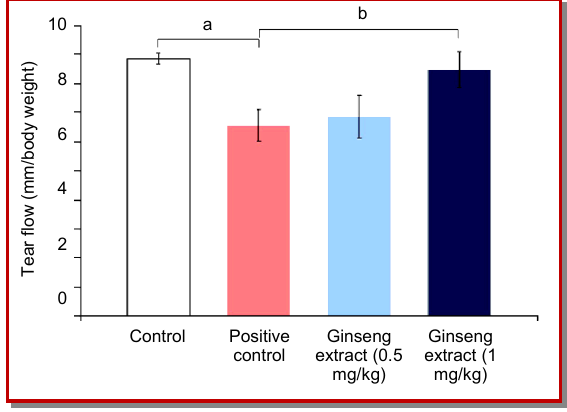
Figure 1: Effects of ginseng extract (0.5 and 1 mg/kg) admin- istration on tear secretion in benzalkonium chloride-induced dry eye syndrome mouse model. Results are expressed as mean ± SD; (n=4, a p<0.01, b p<0.001)